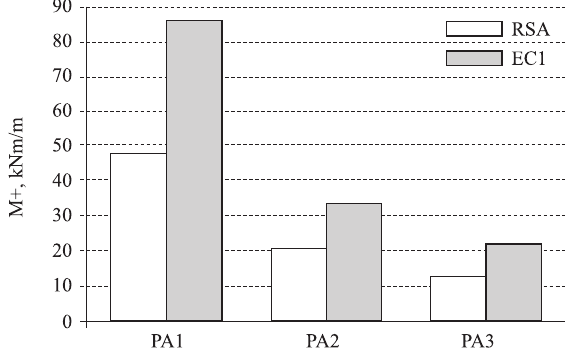
Fig. 7. Magnitude of maximum positive bending moments (M+) for RSA and EC1 standard